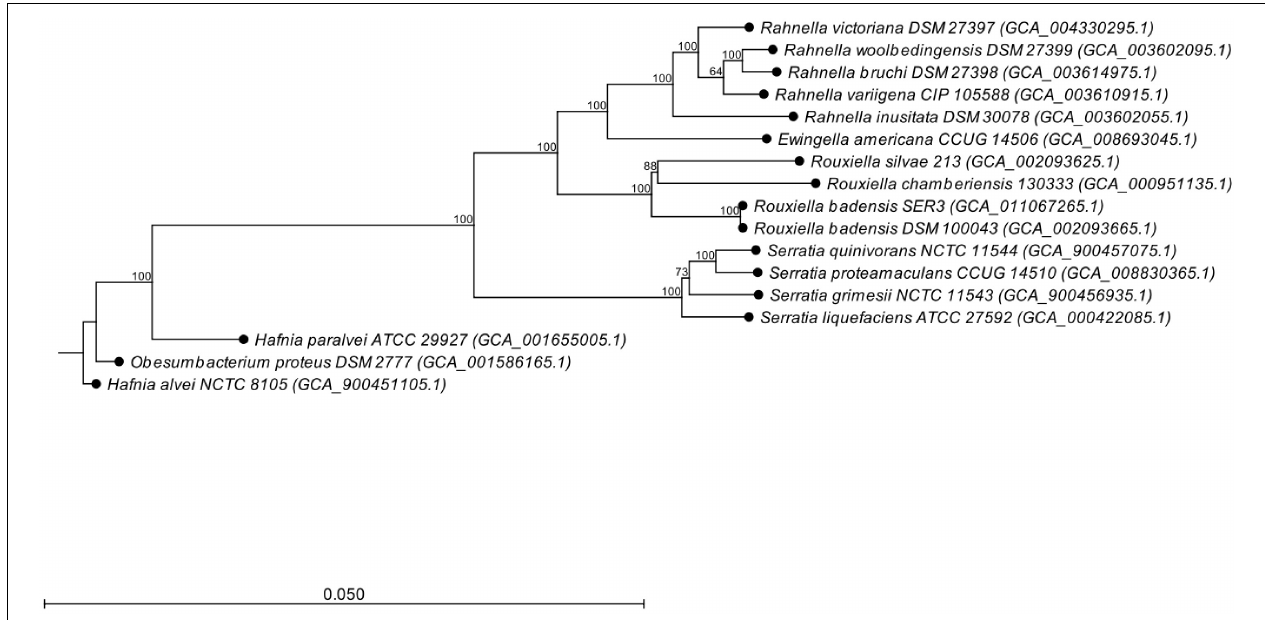
FIGURE 7 | Phylogenomic tree based on the whole genome sequence data of Rouxiella badensis strain SER3, including the relationship with other bacterial species. The phylogenetic tree was constructed using the neighbor-joining algorithm. Bootstrap analysis of 1,000 replications was performed and is expressed as a percentage. Hafnia alvei NCTC 8,105 was used as an